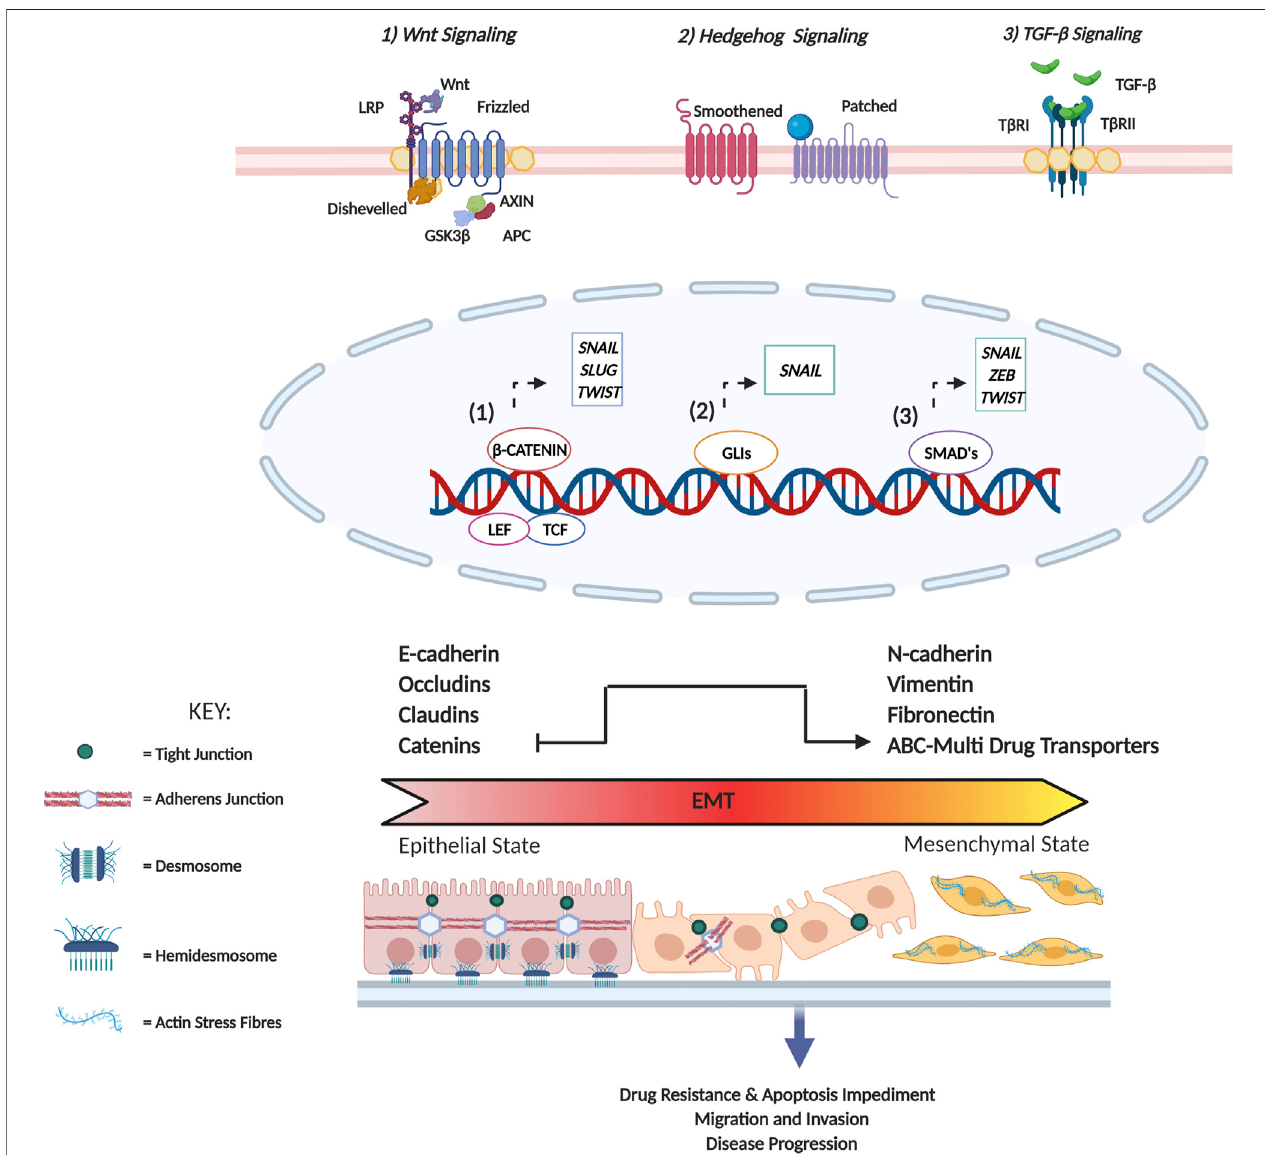
FIGURE 2 | Summary of EMT induced changes in cellular physiology. In tissues, epithelial cells are often arranged as either a single layer or exist as multi-layered sheets. These cells are characterized by the presence of specialized contacts called cell junctions that facilitate cell-cell interaction (cadherin-based adherens junctions, tightjunctions,anddesmosomes)aswellascell-matrixinteractions(hemidesmosomes)thatmaintainstructuralintegrityandapical-basalpolarity.Intermsofcytoskeletal composition, Type I intermediate fi laments such as cytokeratins are expressed, and adherens junctions serve to indirectly connect cortical actin fi laments of two adjacentcells.Onthecontrary,mesenchymalcellsarecharacterizedbyminimalcelljunctionsanddetachedstromalarrangementspromotingfront-rearpolarity.Interms of cytoskeletal composition, vimentin is predominantly expressed to enhance cytoskeletal strength contributing to cell fl exibility, and actin fi bres arrange to form stress fi bres.Additionally,theformationofactin-richmembraneprojectionsfacilitatescellular movement aswellassensoryreception.Characteristic surfacemarkersutilizedto identify epithelial cells include E-cadherin, cytokeratins, occludins as well as claudins, while mesenchymal cells are identi fi ed based on the presence of N-cadherin, fi bronectin, and vimentin. Cellular stimuli lead to the activation of several signaling pathways (Wnt, Sonic Hedgehog and TGF- β ) that promote the expression of master EMTTFs(SNAIL,SLUG,TWISTandZEB).FollowingactivationoftheEMTprogramtheseTFsfacilitatethelossofseveraloftheaforementionedepithelialcharacteristics, promote cytoskeletal remodeling and initiate a concomitant gain of mesenchymal traits. This transition consequently facilitates a change in cell morphology from squamous, cuboidal, columnar to a fi broblast/spindle-like morphology conferring upon cancer cells migratory and invasive potential.